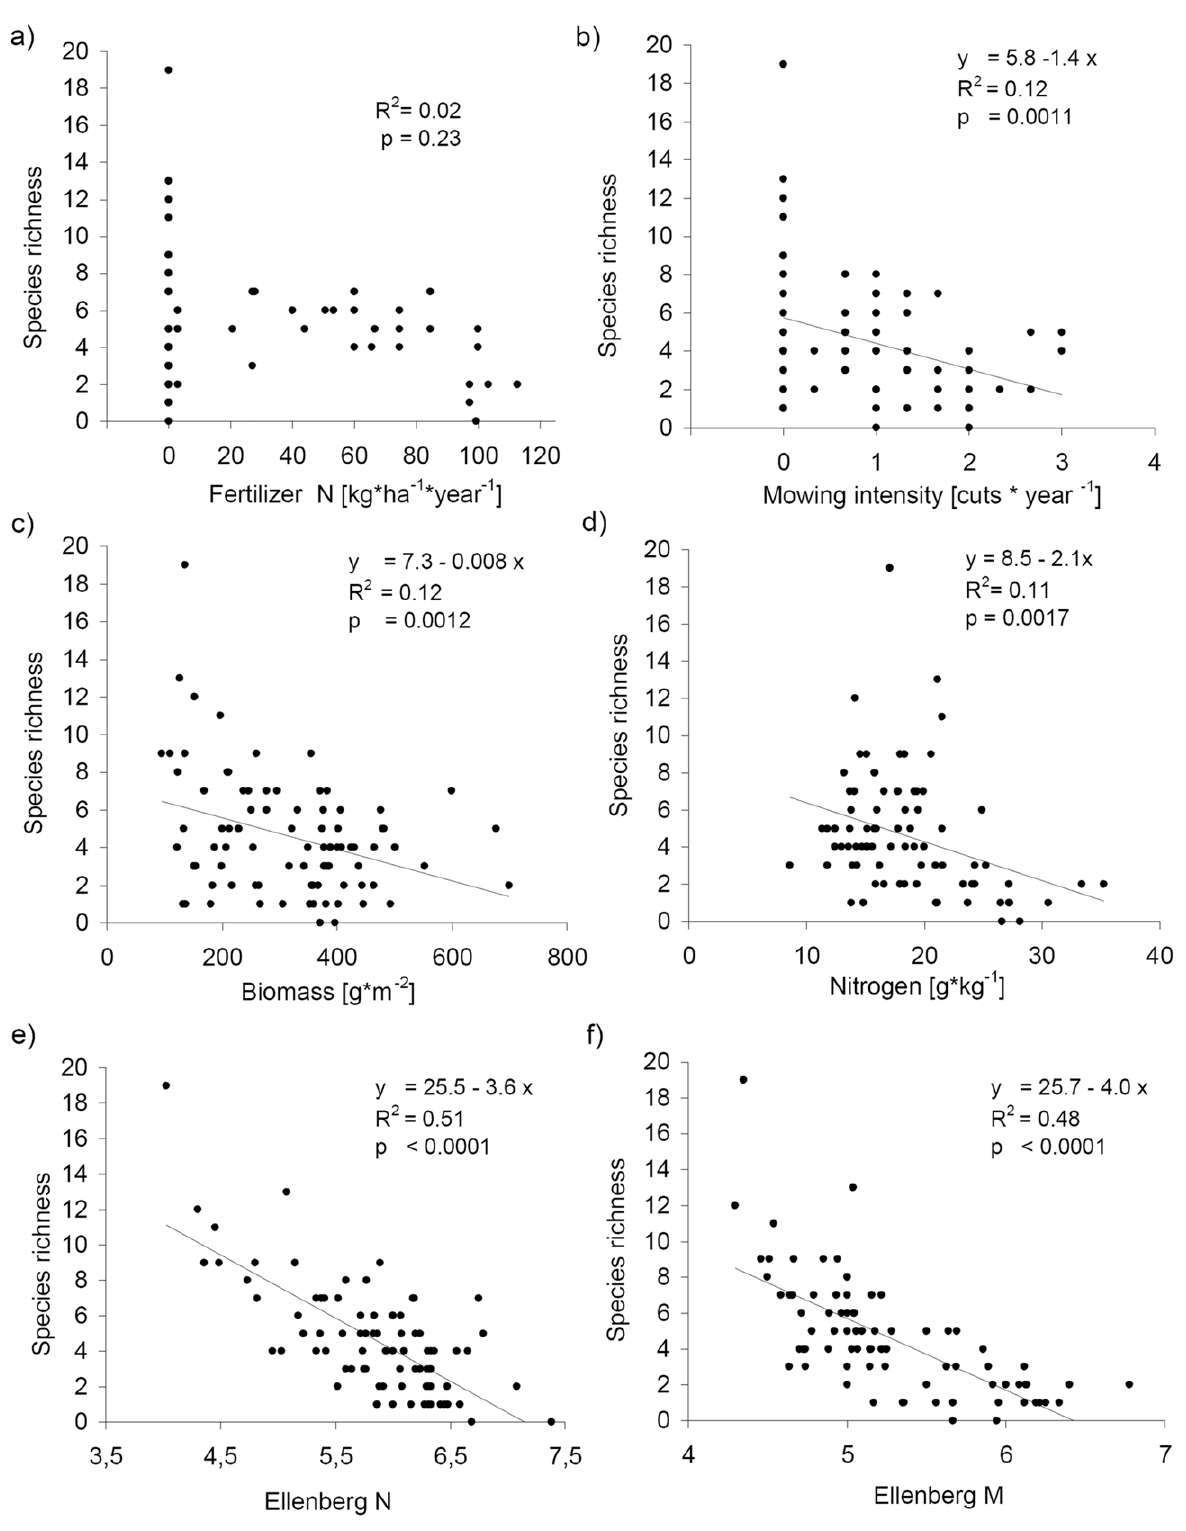
Figure 4. Relationships between bryophyte species richness and intensities of land-use and productivity. Relationships between total bryophyte species richness and intensities of land-use practices, mean annual amount of N fertilizer [kg*ha 2 1 *year 2 1 ]; mean annual number of cuts [Cuts*year 2 1 ] from 2006–2008, aboveground community biomass of vascular plants [g*m 2 2 ], Nitrogen concentrations in biomass [[g/kg 2 1 ]], mean Ellenberg indicator values for vascular plants for nutrients (N) and for moisture (M) on 85 grassland plots.